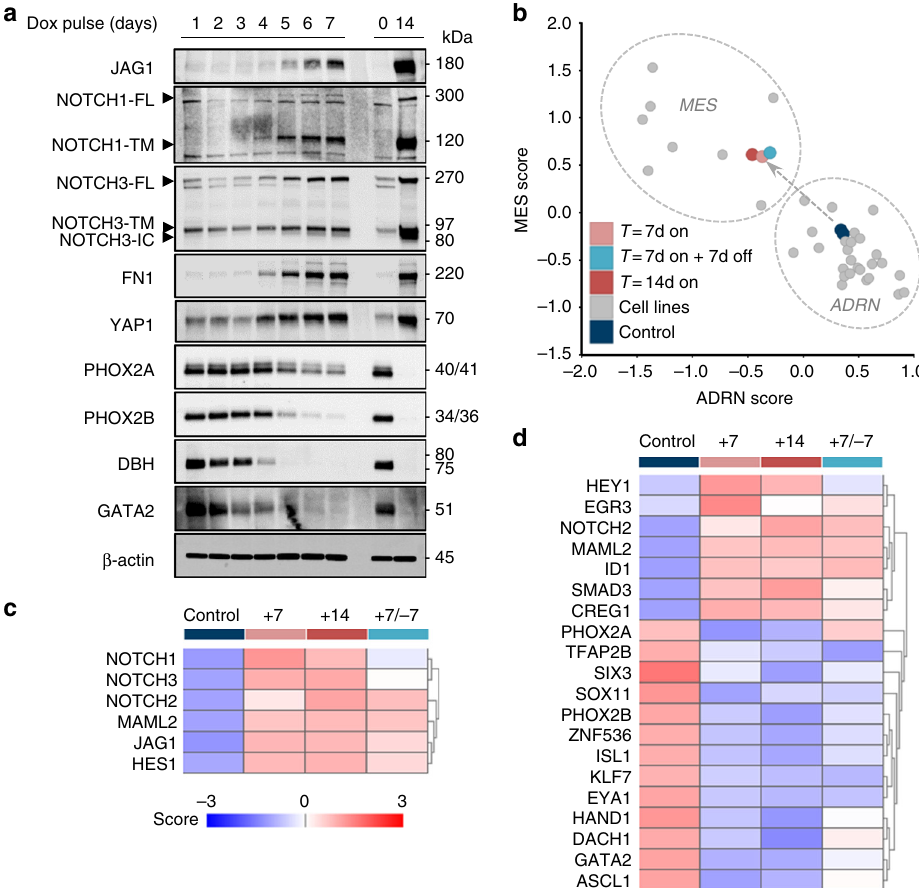
Fig. 6 A transient phase of NOTCH3-IC expression induces commitment to a MES phenotype. a Western blot analysis of transient NOTCH3-IC induction. Time of doxycycline (dox) induction is indicated above the blots. Induction was followed by doxycycline wash-out and all samples were harvested after T = 14 days. Immunoblots show NOTCH pathway proteins (JAG1, NOTCH1, and NOTCH3), MES-markers (FN1 and YAP1) and ADRN-markers (PHOX2A, PHOX2B, DBH, and GATA2). As a positive reference, a sample of continued NOTCH3-IC induction for T = 14 days was run on the same gel (right). β -actin was used as loading control. Source data are provided as a Source Data fi le. b Summed z-scores of mRNA signatures for MES and ADRN genesets. Non- induced control ( − dox) cells are shown in dark blue. Persistent NOTCH3-IC induction of T = 7 and 14 days are shown in pink and red, respectively. A transient phase of NOTCH3-IC induction ( T = 7 days + doxycycline, followed by T = 7 days - doxycycline wash-out) is shown in light blue. As a reference, various neuroblastoma cell lines are shown in gray dots and grouped by dashed lines according to MES and ADRN phenotypes (see ref. 1 ). c , d mRNA analysis (z-score of expression) of C) NOTCH pathway genes and D) core transcription factors of MES and ADRN lineages. + and — indicate culture conditions with or without doxycycline, respectively. Time of doxycycline treatment is indicated in days. For color-coding of samples, see panel